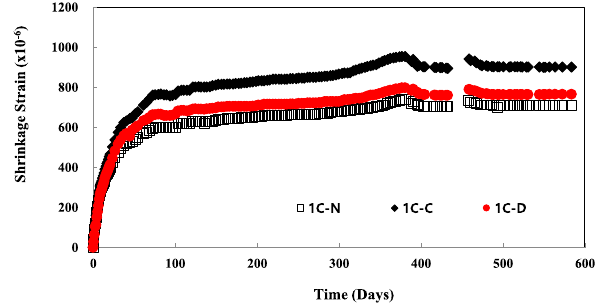
Fig. 7 Effect of aggregate sources on drying shrinkage for mix series